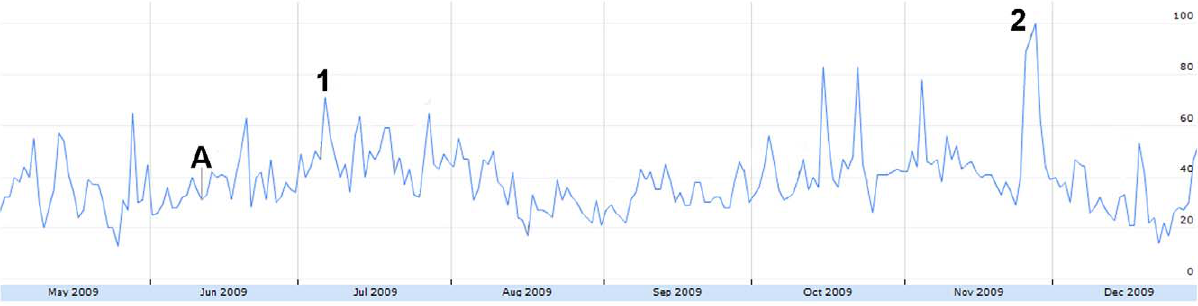
Figure 10. The relative proportion of tweets expressing relief from May 1 to December 31, 2009. Figure was scaled to the highest peak on Nov. 27 where 1.33% of all tweets expressed relief. The peak was assigned a score of 100. A=June 11: WHO pandemic level 6 announcement. 1=July 5: Harry Potter actor Rupert Grint has H1N1. 2=Nov 25–27: # iamthankfulfor campaign.